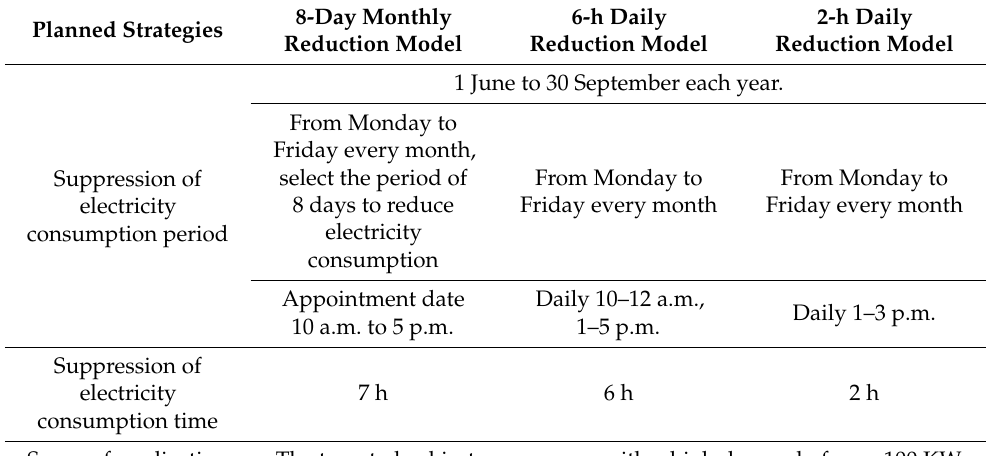
Table 1. Planned electricity reduction